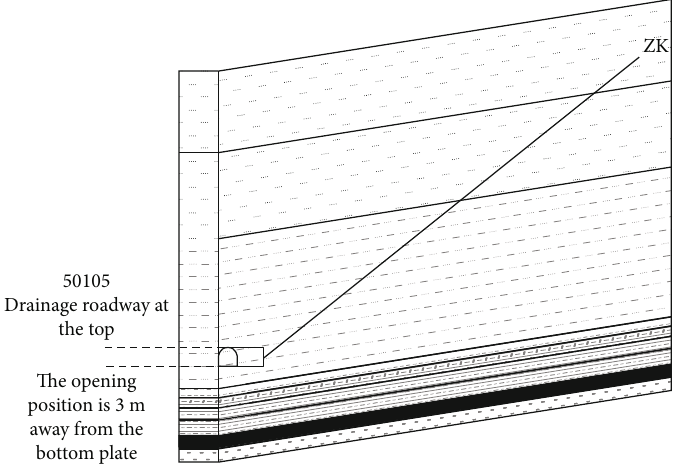
Figure 8: Geological section of the electrical probe hole control